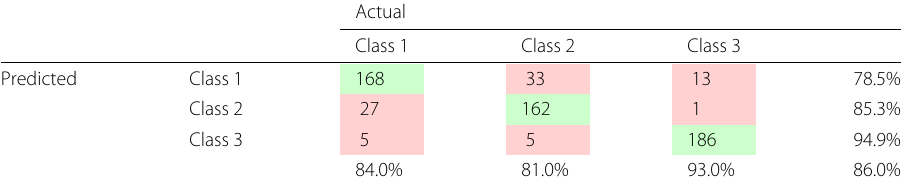
Table 7 Confusion matrix using features obtained with LSP-HATS. Total classification accuracy is